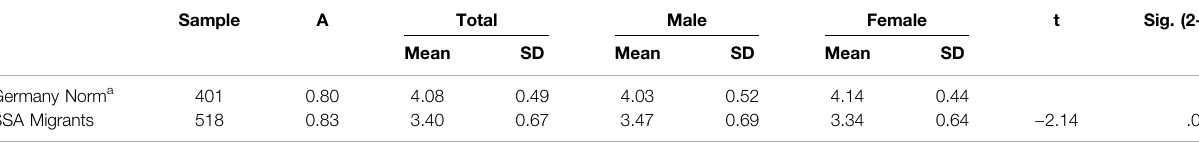
TABLE 2 | Descriptive and psychometric properties for the total quality of life score. Sample